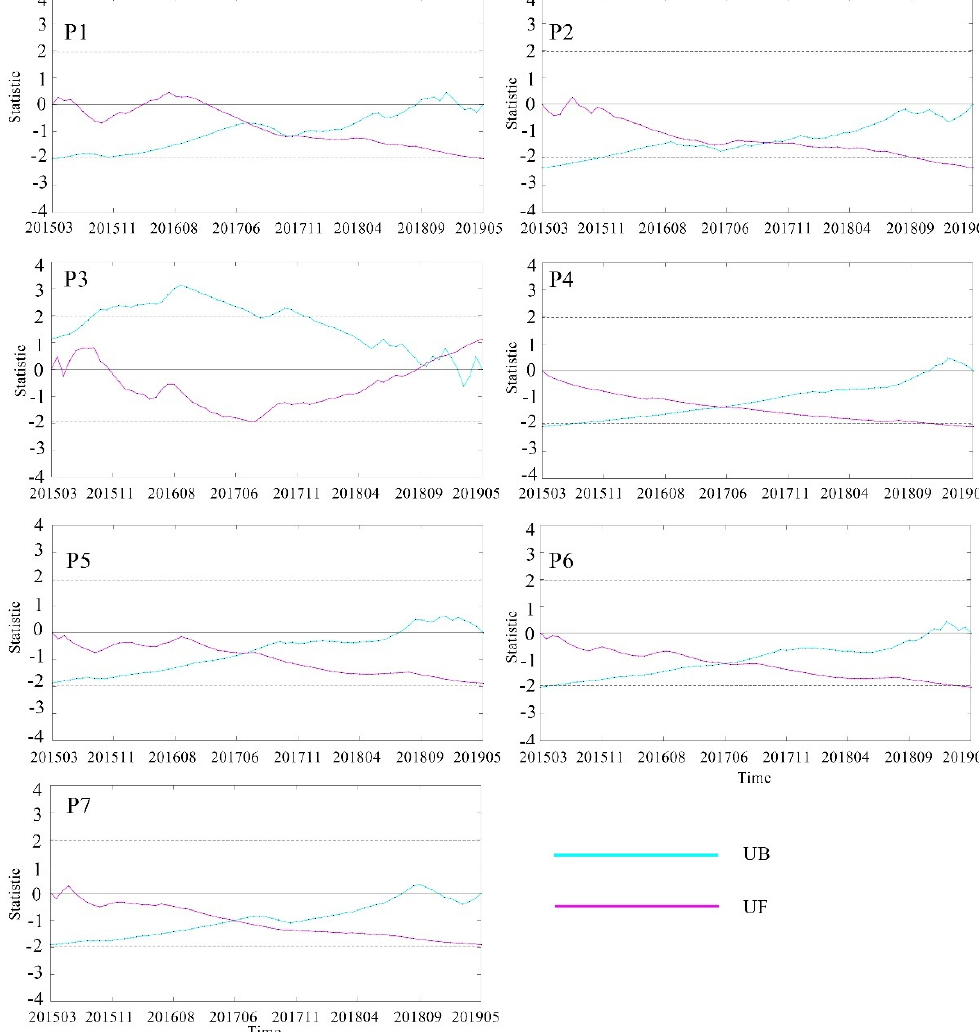
Figure 9. The Mann–Kendall test surface deformation trend analysis results for Regions P1 − P7 during 2015 − 2019.